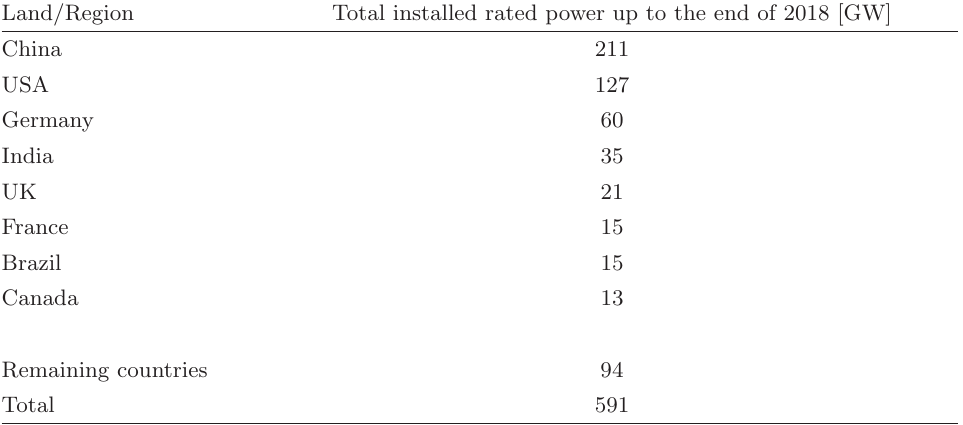
Table II. – World wind power production. This statistic is taken from [2] .